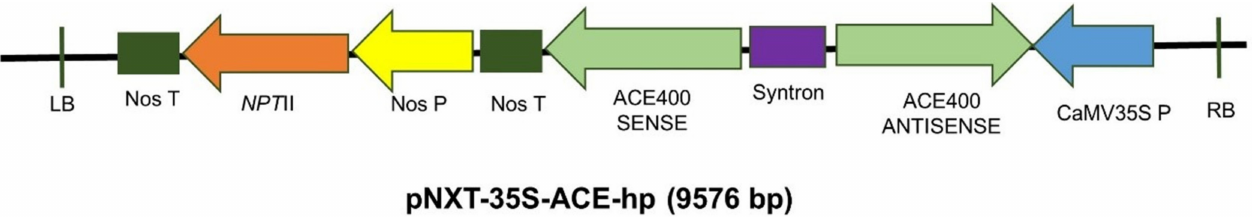
Figure 9. A graphical representation of the T-DNA region of the pNXT-35S-ACE hp